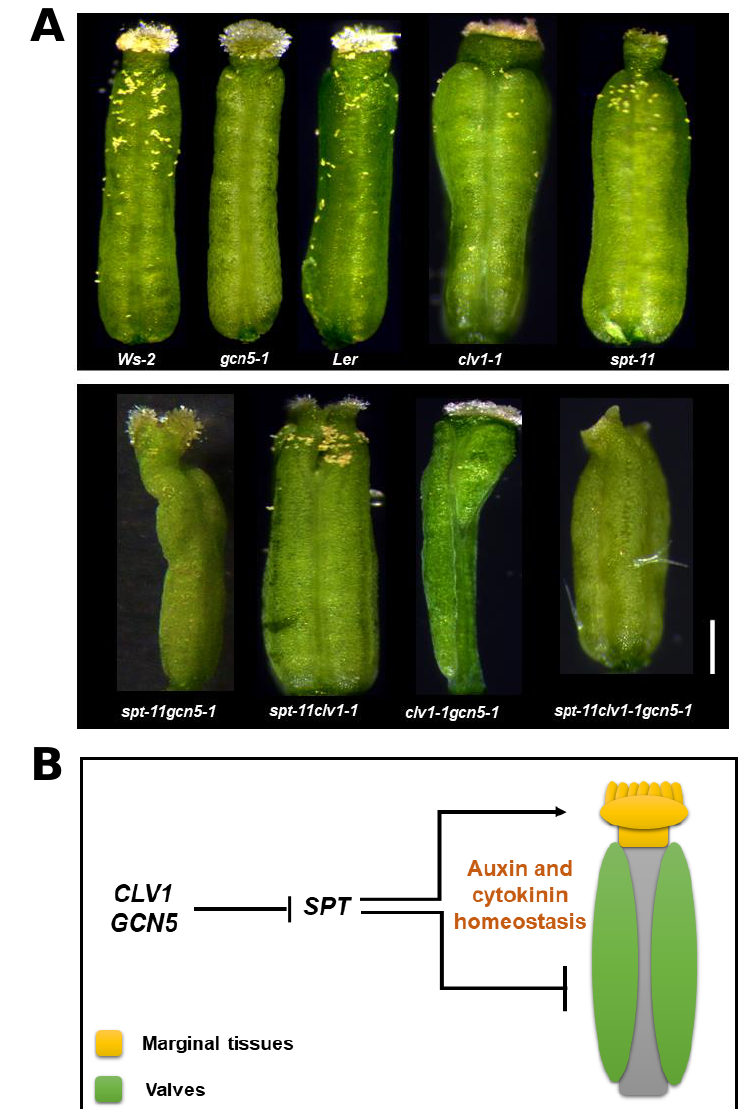
Figure 3. Genetic interactions between GCN5, CLV1, and SPT. ( A ) Stereoscopic images of representa- tive gynoecia from stage 13 flowers of each genotype are shown. The white bar represents 250 µ m. ( B ) A genetic model for the role of SPT, CLV1 , and GCN5 in gynoecium